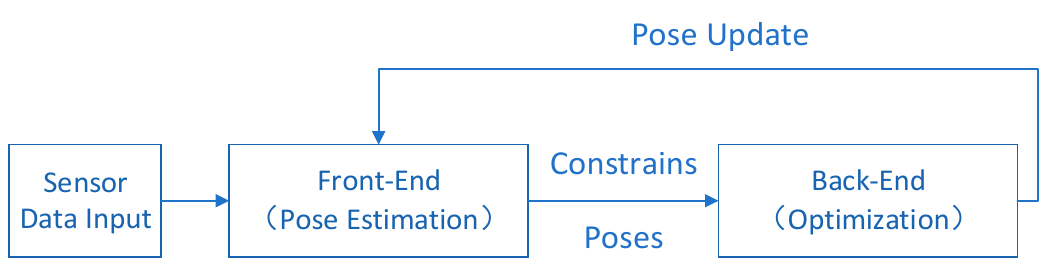
Figure 1. A general graph-based light detection and ranging (SLAM) framework.